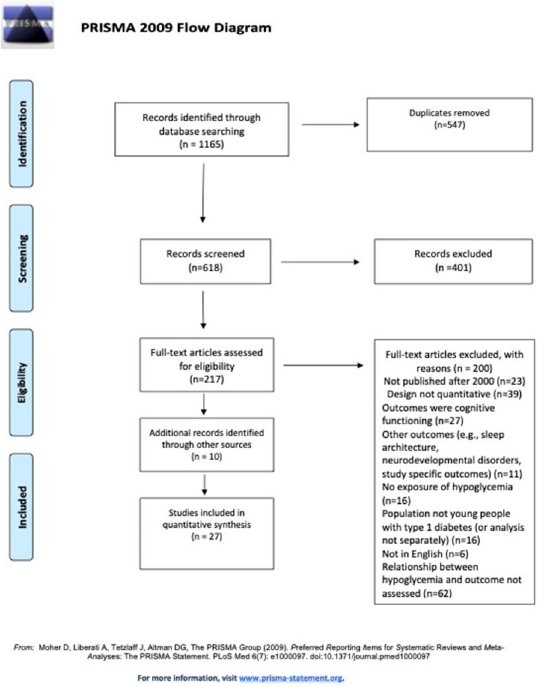
Fig 1. PRISMA flowchart of the systematic search and screening, reasons for exclusions, and final number of included studies.